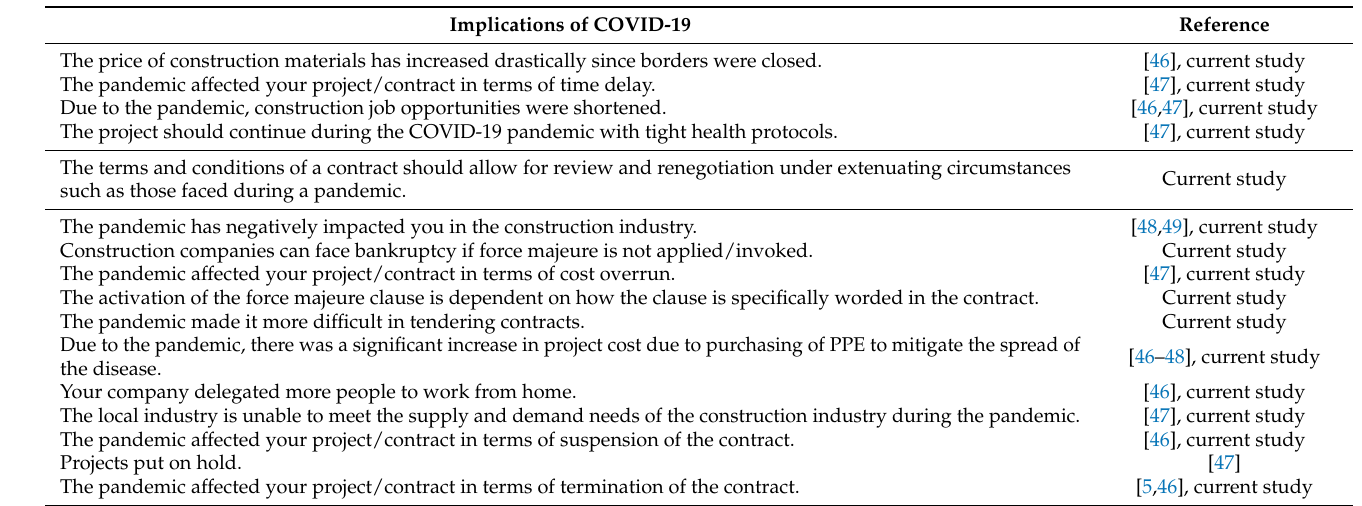
Table 9. Comparison between the implications identified through the current study and the previous